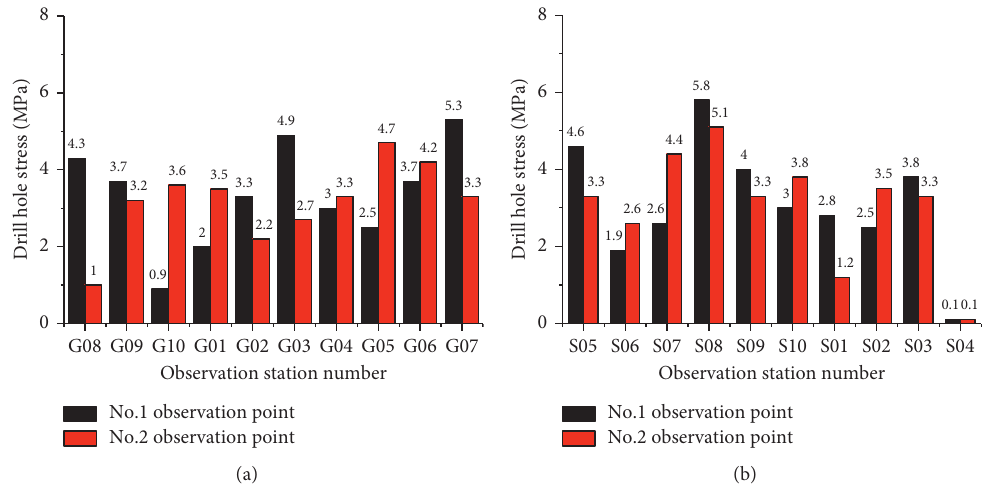
Figure 14: Stress monitoring results of No. 1412 working face on March 1. (a) No. 1412 upper roadway. (b) No. 1412 lower roadway.